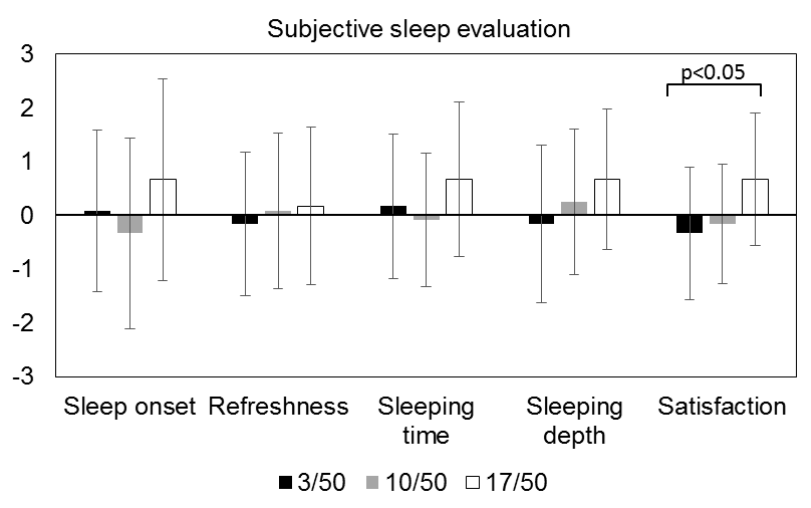
Figure 3. Average (SD) rating of sleep evaluation, sleep onset, refresh, sleeping time, sleeping depth and satisfaction.